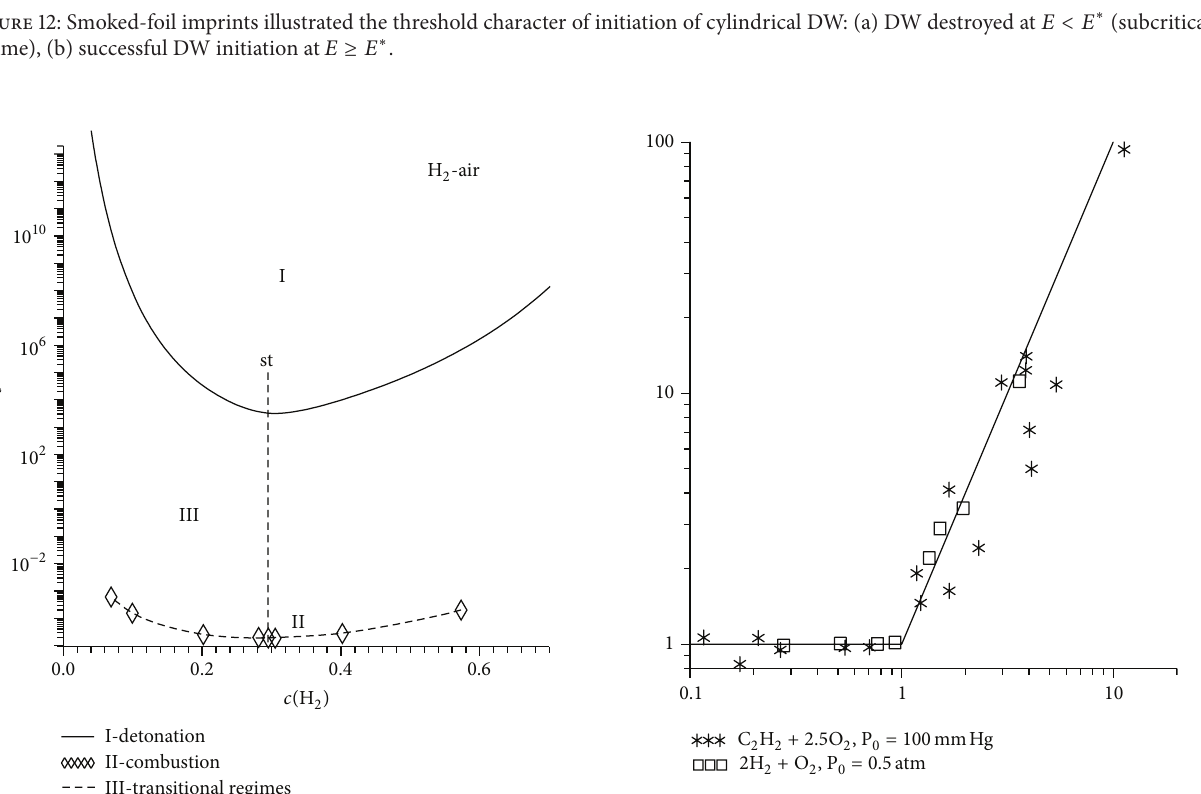
Figure 13: The graph of critical energies of ignition and initiation of detonation on molar fuel concentration for hydrogen-air mixtures.